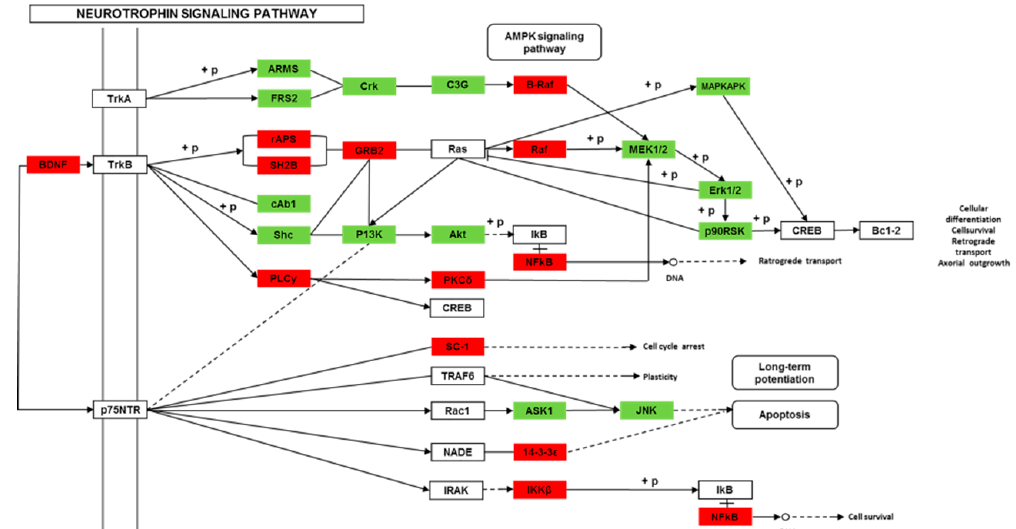
Figure 4. Di ff erentially expressed genes in the neurotrophin signaling pathway between mandarin fish at CG and LG from a transcriptome analysis. The colors of the rectangles were shaded according to the di ff erent expression (red: The mRNA expression levels of fish in Group LG were significantly higher than those in Group CG (FDR ≤ 0.001, the absolute value of log2 (Ratio) ≥ 1); green: The mRNA expression levels of fish in Group LG were significantly lower than those in Group CG (FDR ≤ 0.001, the absolute value of log2 (Ratio) ≥ 1)).